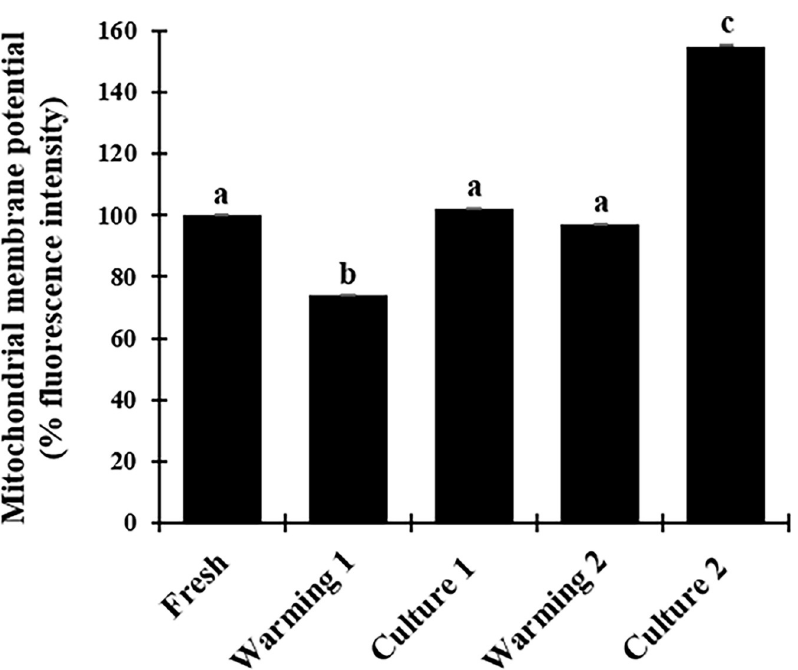
Fig 5. Fluorescence intensity of mitochondrial membrane potential in testicular tissue from prepubertal cats. Data are expressed as mean ± SE (n = 6 animals per treatment). Warming 1 (tissue warmed at 37˚C), culture 1 (warming 1 followed by culture for 24h), warming 2 (tissue warmed at 50˚C), culture 2 (warming 2 followed by culture for 24h). Different letters above bars indicate significant statistical differences between treatments (P < 0.05). Percentages of germ cells labeled with Boule were similar (P > 0.05) in fresh tissues (48.4% ± 6.9) and after warming (55.8% ± 3.4). After culture for 24 h (76.5% ± 1.3) or 5 days (77.0 ± 2.9), percentages were higher (P < 0.05) than in the other groups (Figs 9B and 10).